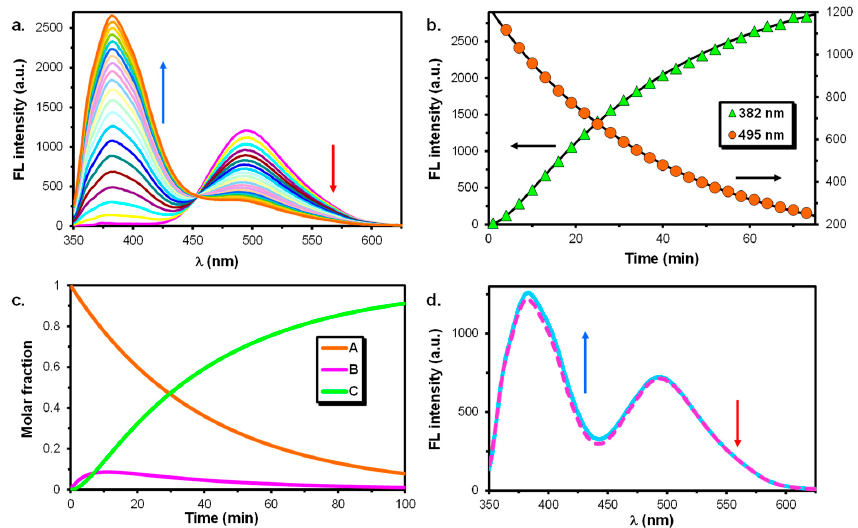
Figure 1. The evolution of the emission spectra during the reaction of 1,5-ICAN with water and HgCl 2 in the mixture of THF / water ( a ). The variations of the fluorescence intensities at λ = 382 nm and 495 nm recorded at 60 s intervals. The symbols show the experimental data, while the solid lines represent the fitted curves by Equations (4) and (5) ( b ). The change of the molar fractions for the components A, B and C calculated by Equations (4) and (5) using the parameters obtained from fitting ( c ). Measured (solid line) and calculated (dashed line) emission spectra at 25 min reaction time ( d ). Experimental conditions: [H 2 O] = 27.8 mol / L (~ 50% (V / V)), [1,5-ICAN] = 2.5 × 10 − 6 mol / L, [HgCl 2 ] = 1.2 × 10 − 3 mol / L and T = 25 ◦